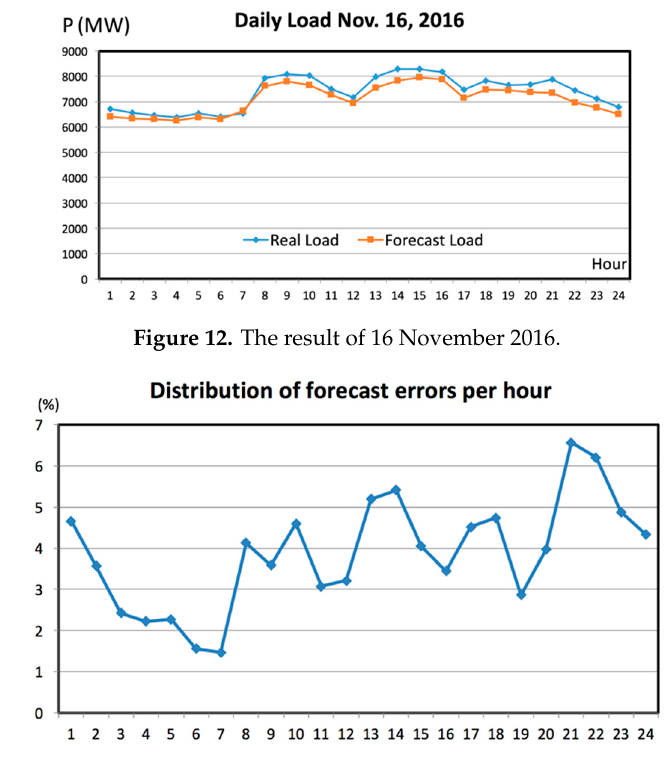
Figure 13. Distribution of forecast errors of 16 November 2016 forecasting.